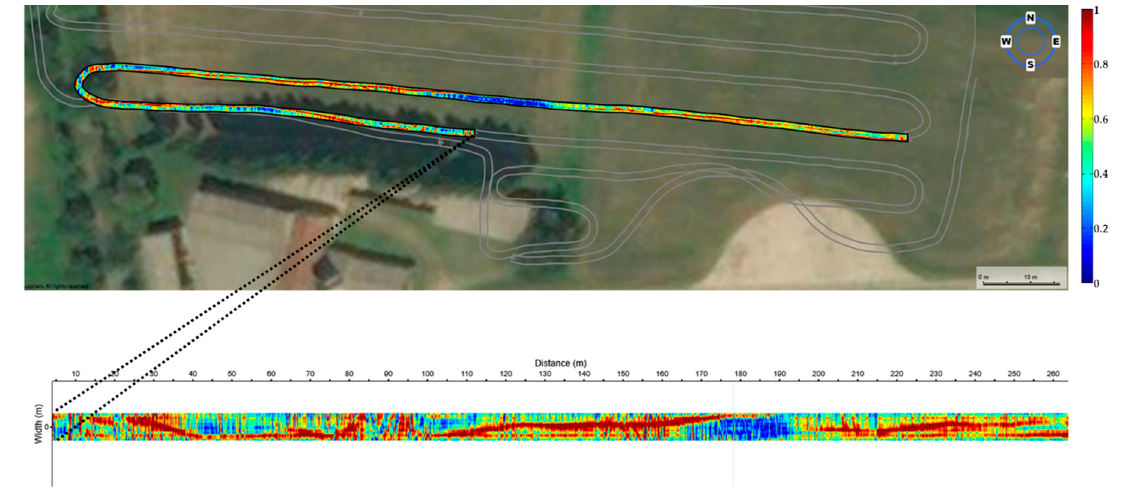
Figure 5. Details on the investigated GPR profile.